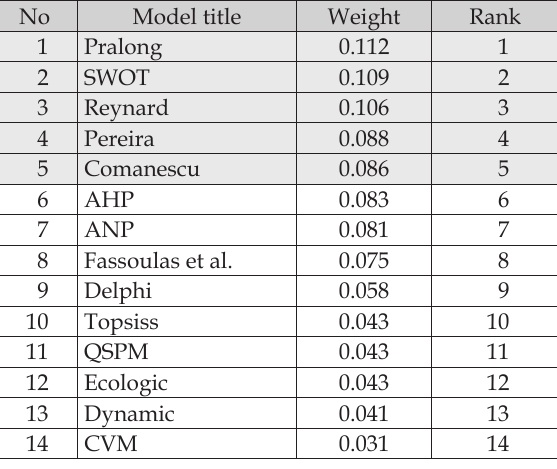
Table 9. The rank of efficient geosites evaluation models based on all